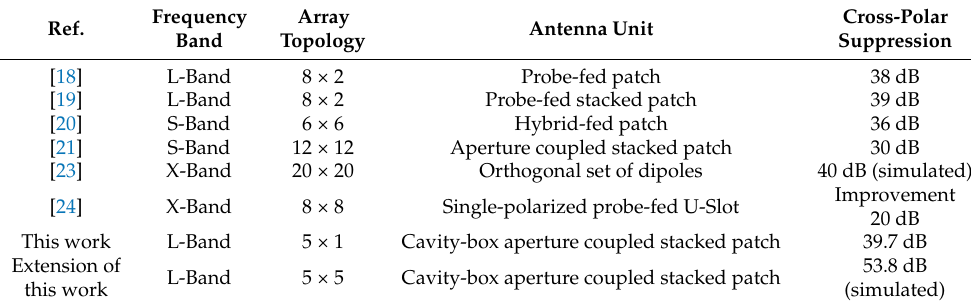
Table 9. Comparison cross-polarization performance of the proposed work with some of the given